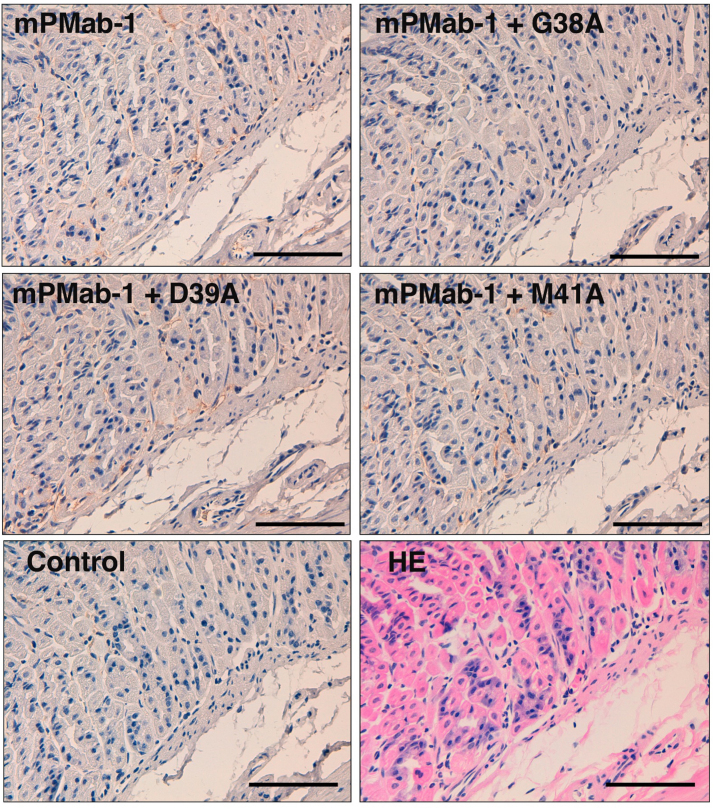
Immunohistochemical analyses. Histological sections of colon tissues were directly autoclaved in citrate buffer for 20 min. After blocking with SuperBlock T20 (PBS) Blocking Buffer, sections were incubated with mPMab-1 (1 μg/ml) or mPMab-1 (1 μg/ml) plus peptides (5 μg/ml), followed by treatment with an Envision+ kit. HE, hematoxylin and eosin. Scale bar, 100 µm. These pictures are magnification of Fig. 4C.